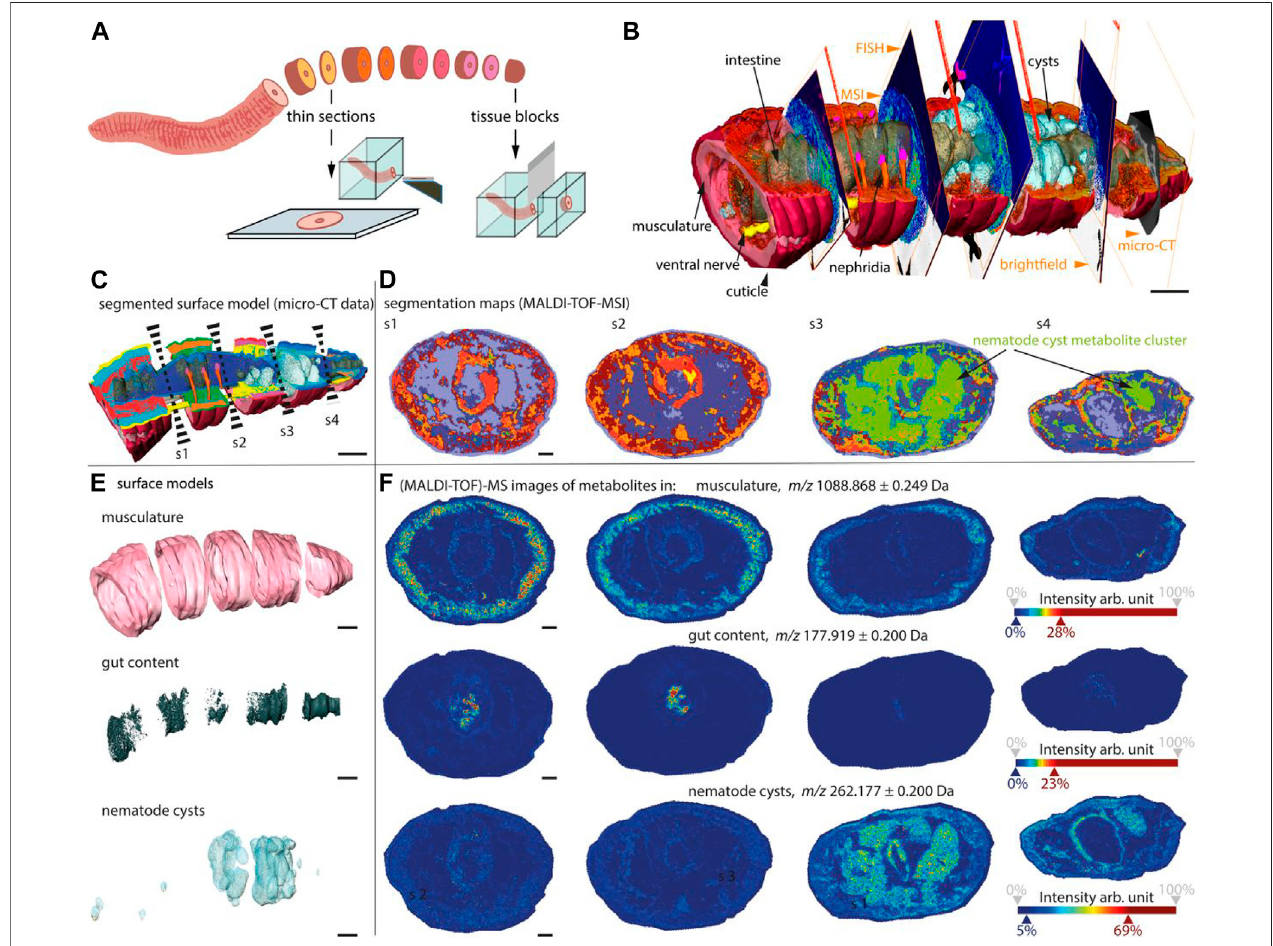
FIGURE 12 | CHEMHIST revealed organ-speci fi c chemistry in the posterior segments of an earthworm (Geier et al., 2021).